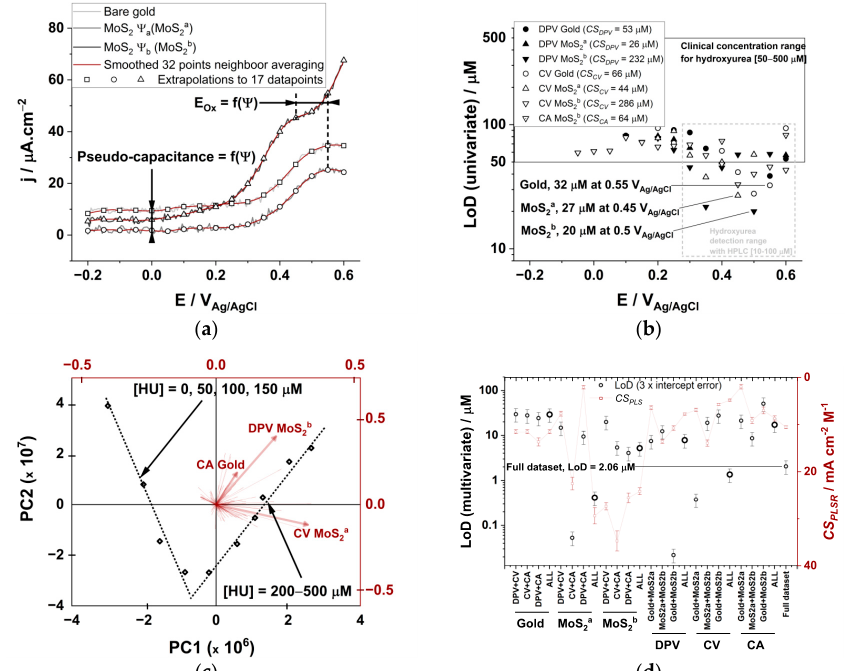
Figure 5. ( a ) DPV analysis of undiluted human serum for the three different electrodes emphasizing the high electrochemical noise recorded upon simultaneous measurements. The variation of the Pseudo-capacitive current and oxidation peak potential is dependent on the electrical waveform used for the electrodeposition of MoS 2 . ( b ) Limit of detection calculated form linear regression analysis of current vs. concentration plots for differential pulse voltammetry (DPV), cyclic voltammetry (CV) and chronoamperometry (CA) for each of the three different electrodes. ( c ) PCA analysis results of the datasets acquired for 10 hydroxyurea concentrations using three electrodes and three electrochemical technics. The loading plot (red) emphasize that each of the technics (DPV, CV, CA) and electrodes constructs (Gold, MoS 2a , MoS 2b ) are used to build the multivariate regression model. ( d ) Limit of detection (black) and combined selectivity of the PLSR analysis (CS PLSR , red) calculated for different array configurations.